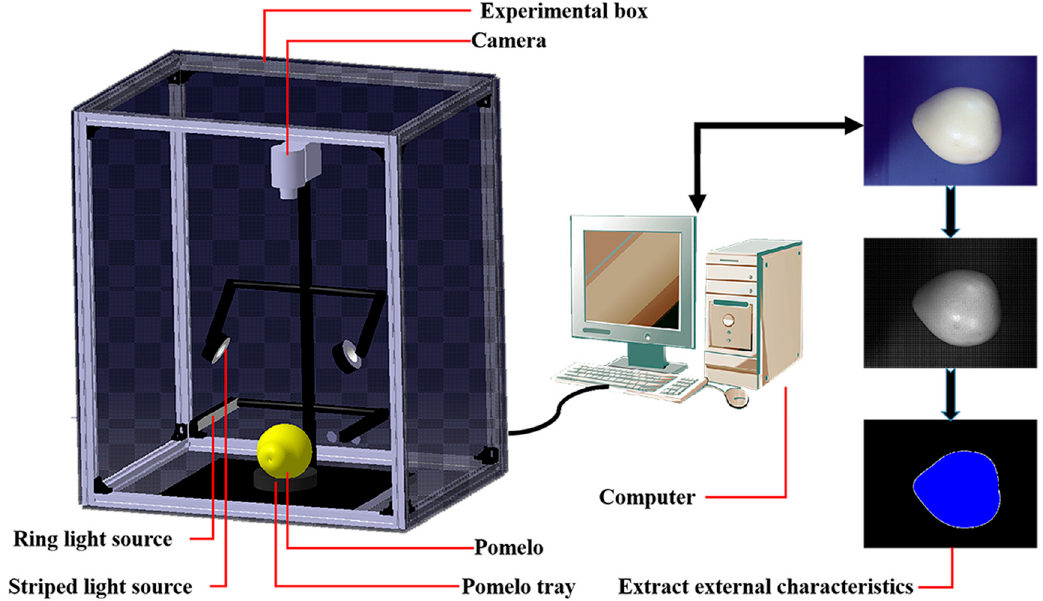
Figure 1. System to acquire image information.